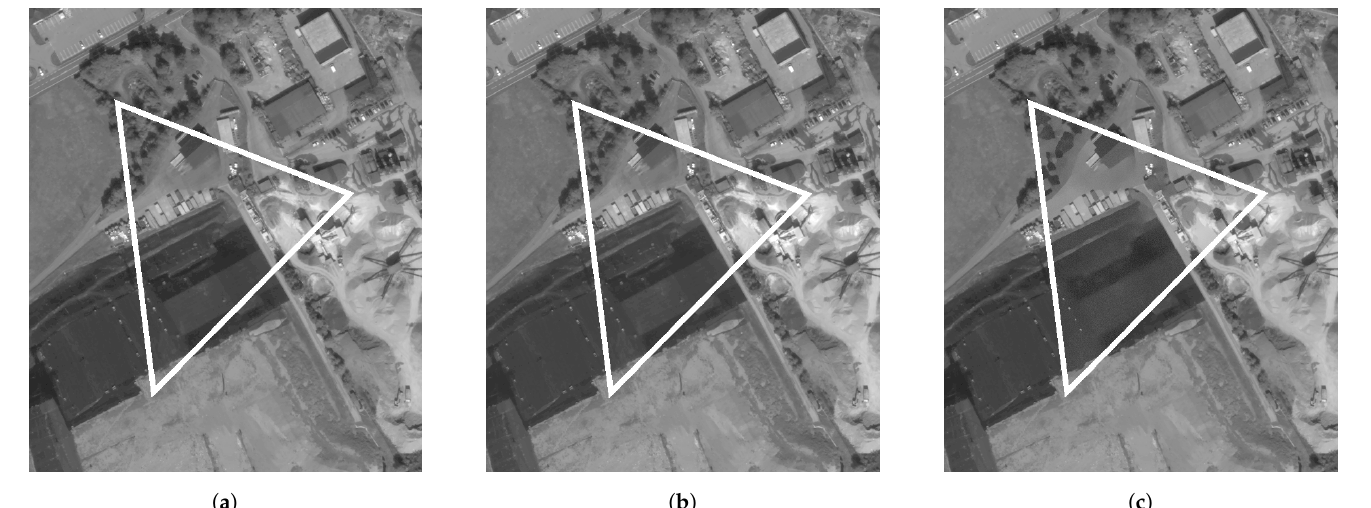
Figure 9. Panchromatic band and radiometric reconstructions—Detail 2. ( a ) WorldView-3 Panchromatic band; ( b ) HM reconstruction; ( c ) ED